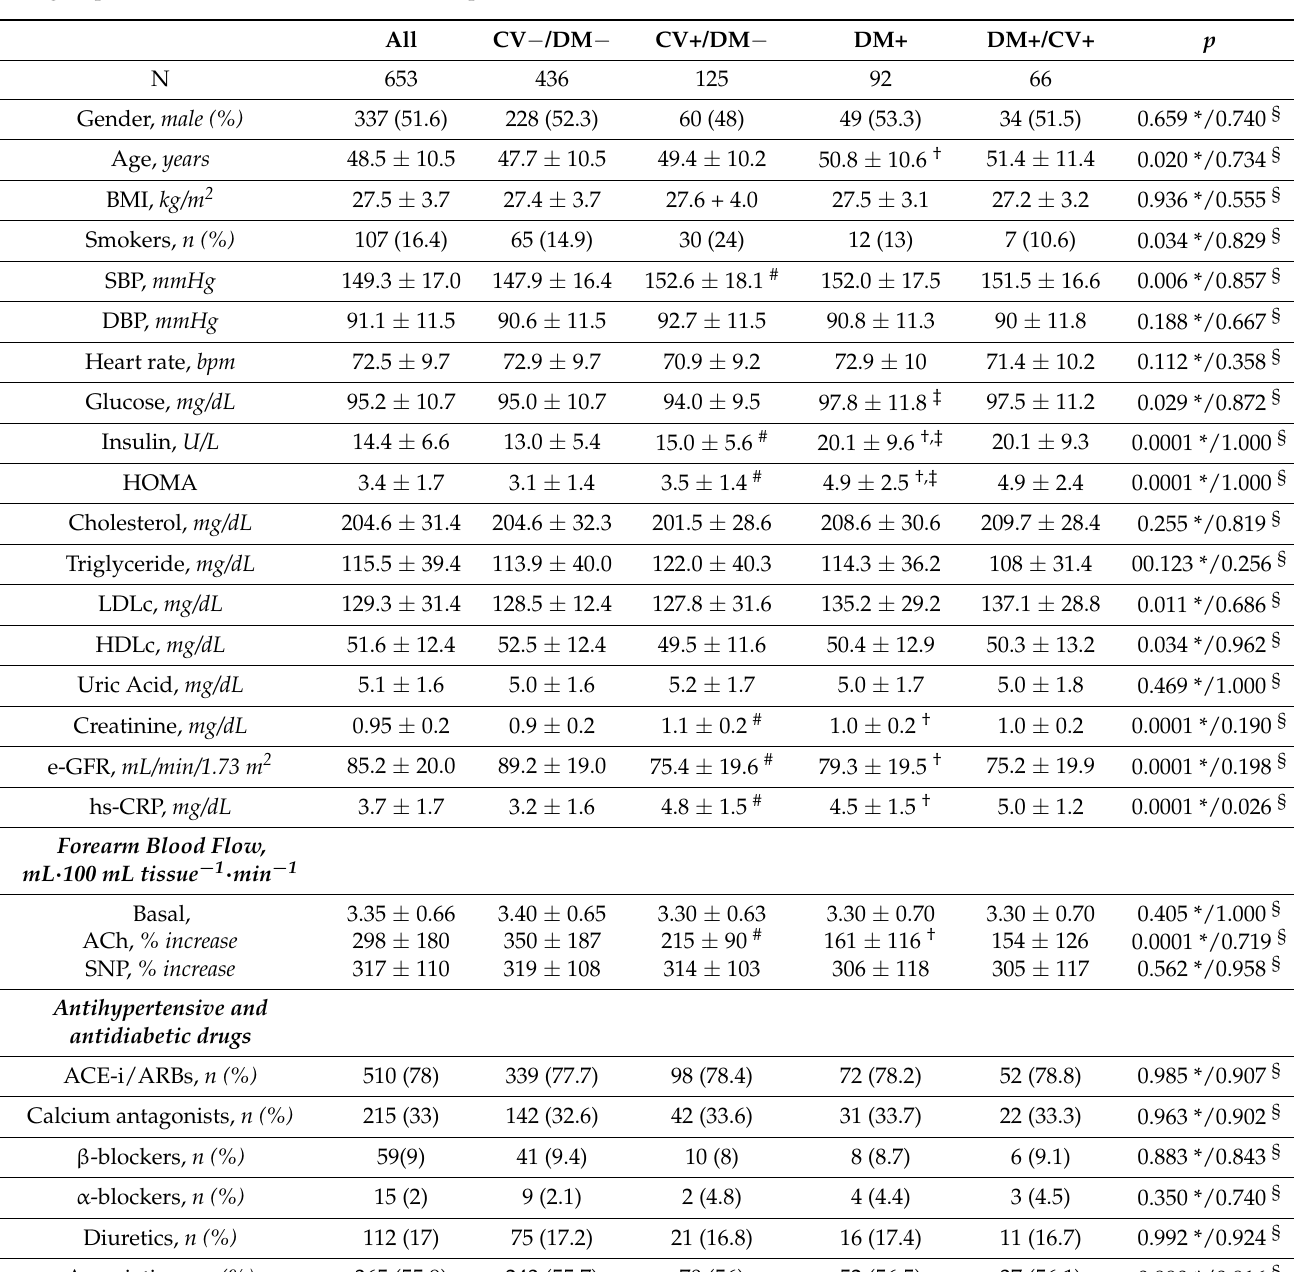
Table 1. Baseline anthropometric, humoral and hemodynamic characteristics of the whole study population and of different groups stratified on the basis of the development of cardiovascular events and/or diabetes.